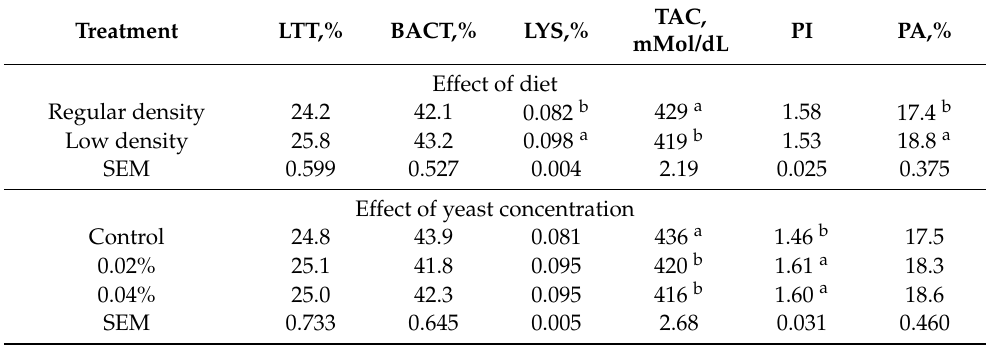
Table 7. Impact of different concentrations of Saccharomyces cerevisiae on immune indices of broilers fed a regular- or low-density diet from 1 to 38 days of